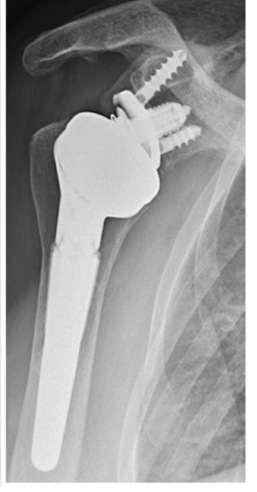
Figure 6. Correct position of the